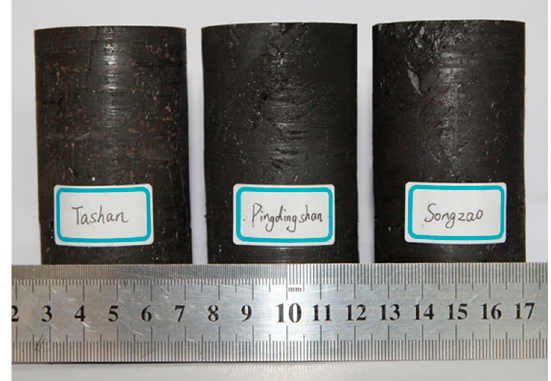
Figure 2. Coal samples from Songzao, Pingdingshan, and Tashan mine. Table 1. The specifications of the samples.